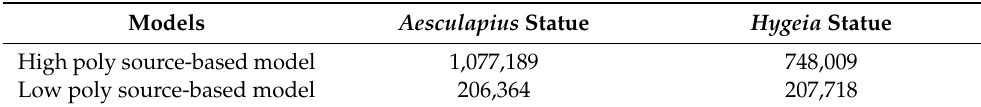
Table 2. Polygon count source-base models: meshes details of the high and low poly models after